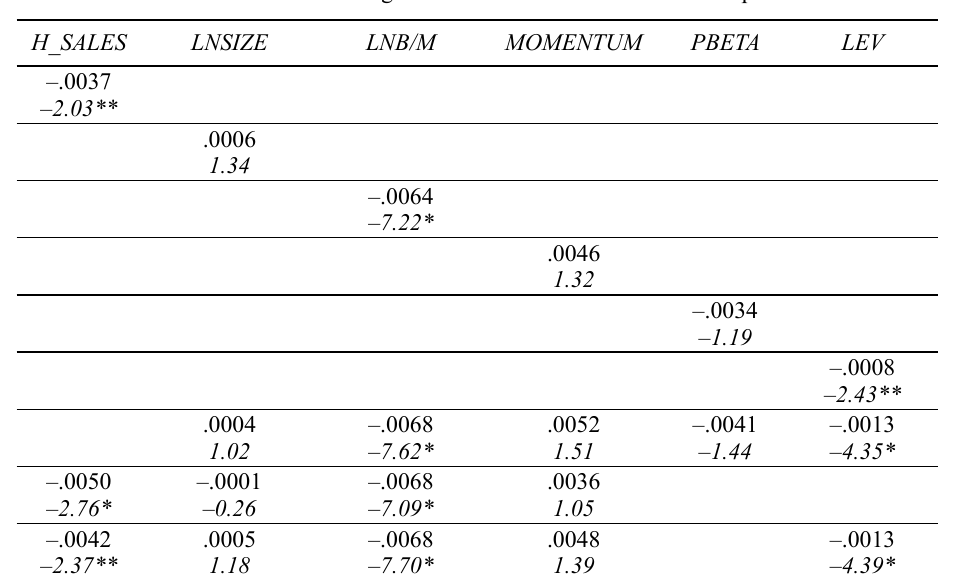
Table 6. Fama-MacBeth regressions of returns on 100 size-beta